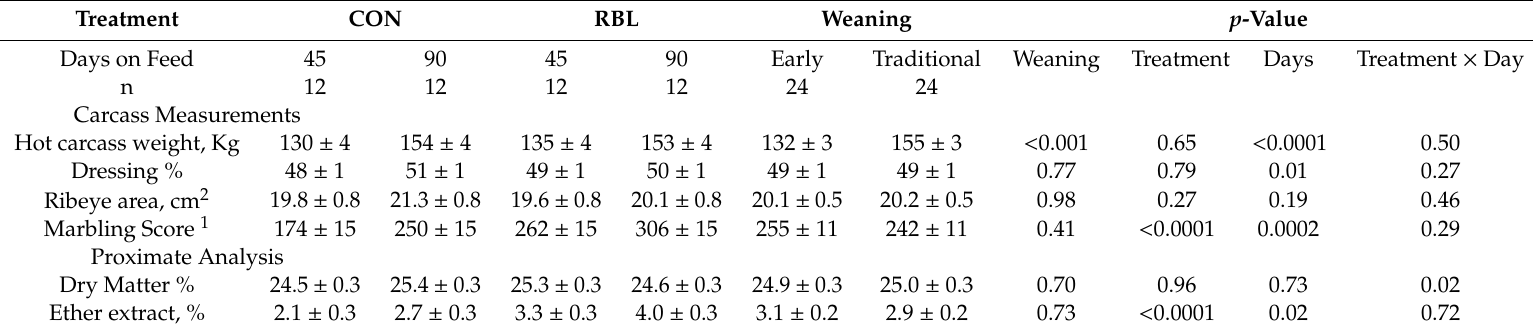
Table 2. Carcass characteristics and proximate analysis values of young steers supplemented with a control (CON) or rumen by-pass (RBL) treatment for either 45 or 90 d (days).